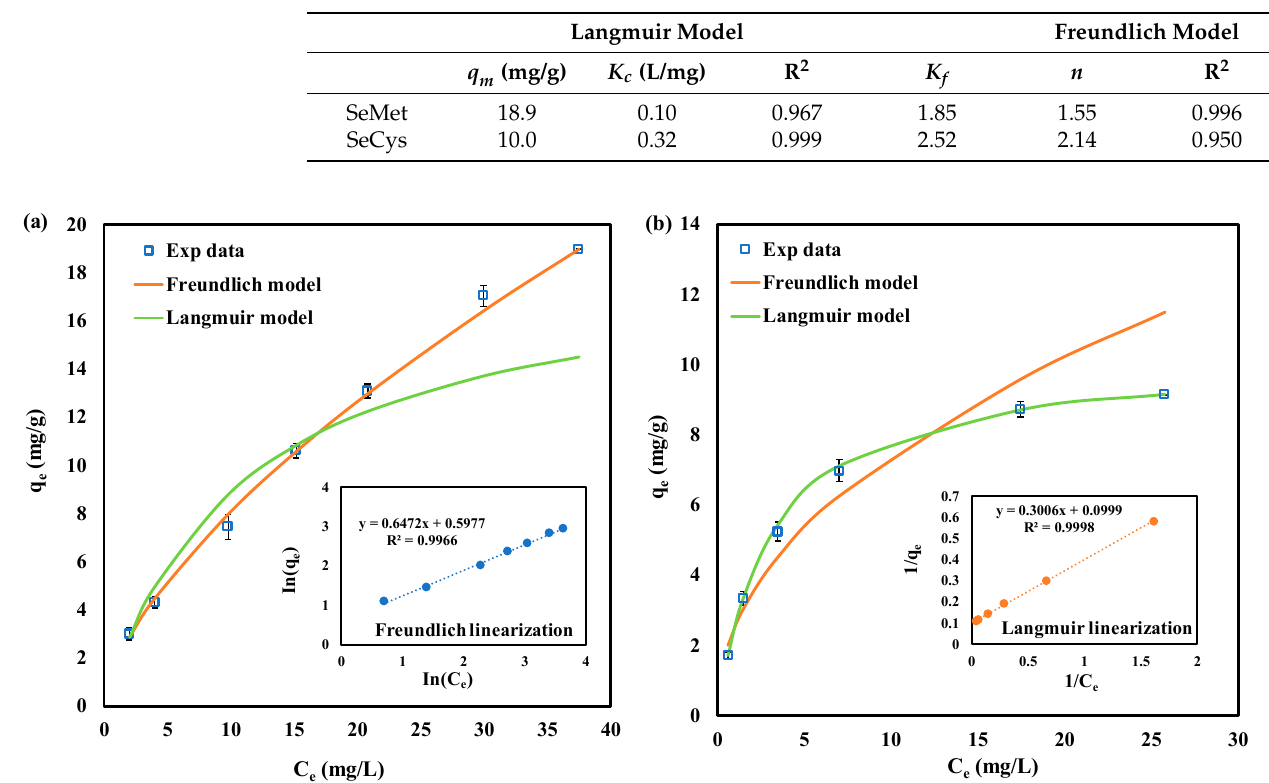
Figure 6. Organic selenium adsorption isotherms by GAC, pH 7.0, at 25 °C. ( a ) SeMet; ( b ) SeCys. The solid lines represent model fits; inset shows a linearization fit. Table 3. Adsorption isotherm parameters for organoselenium by GAC.